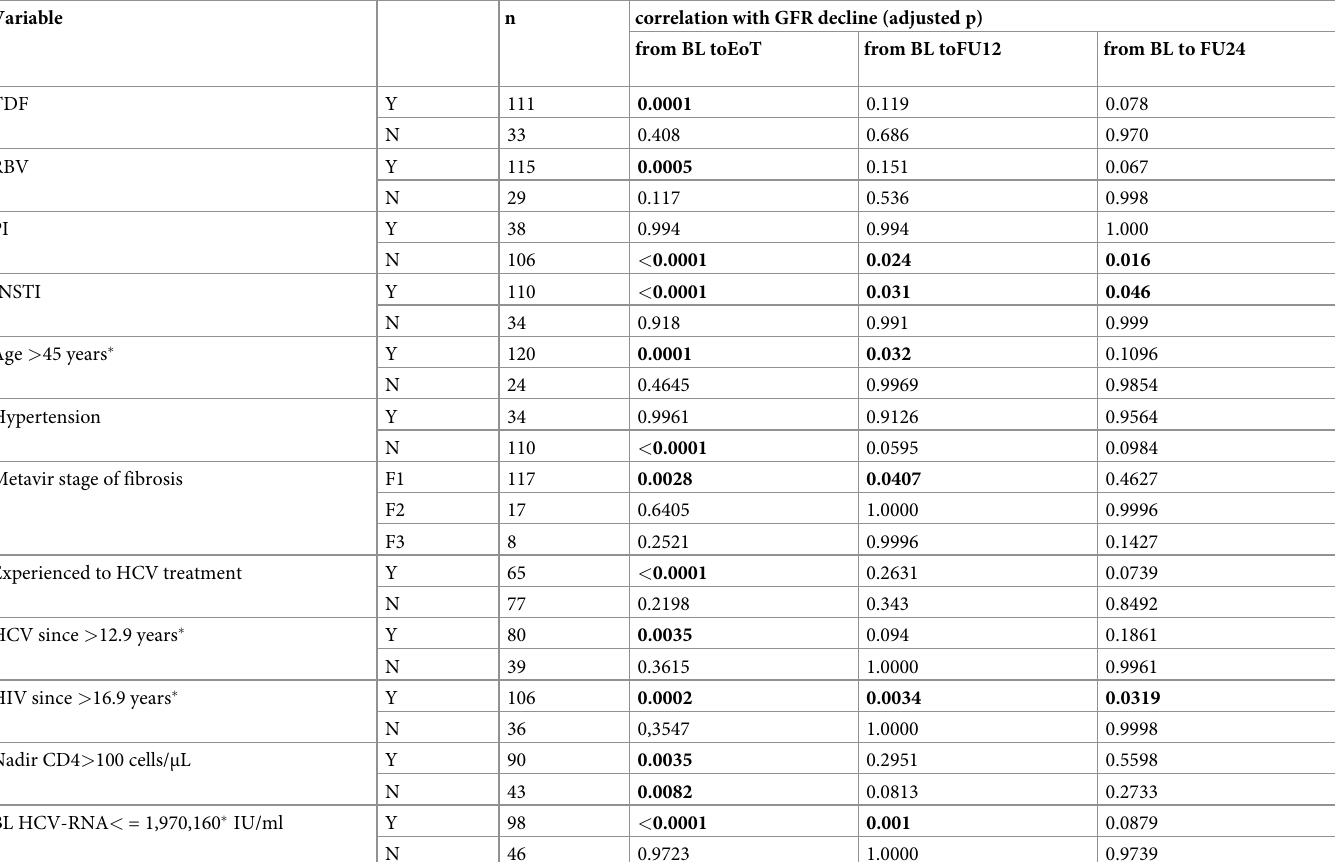
Table 3. Number of patients tested throughout mixed models and correlation with eGFR decline at different time-points.